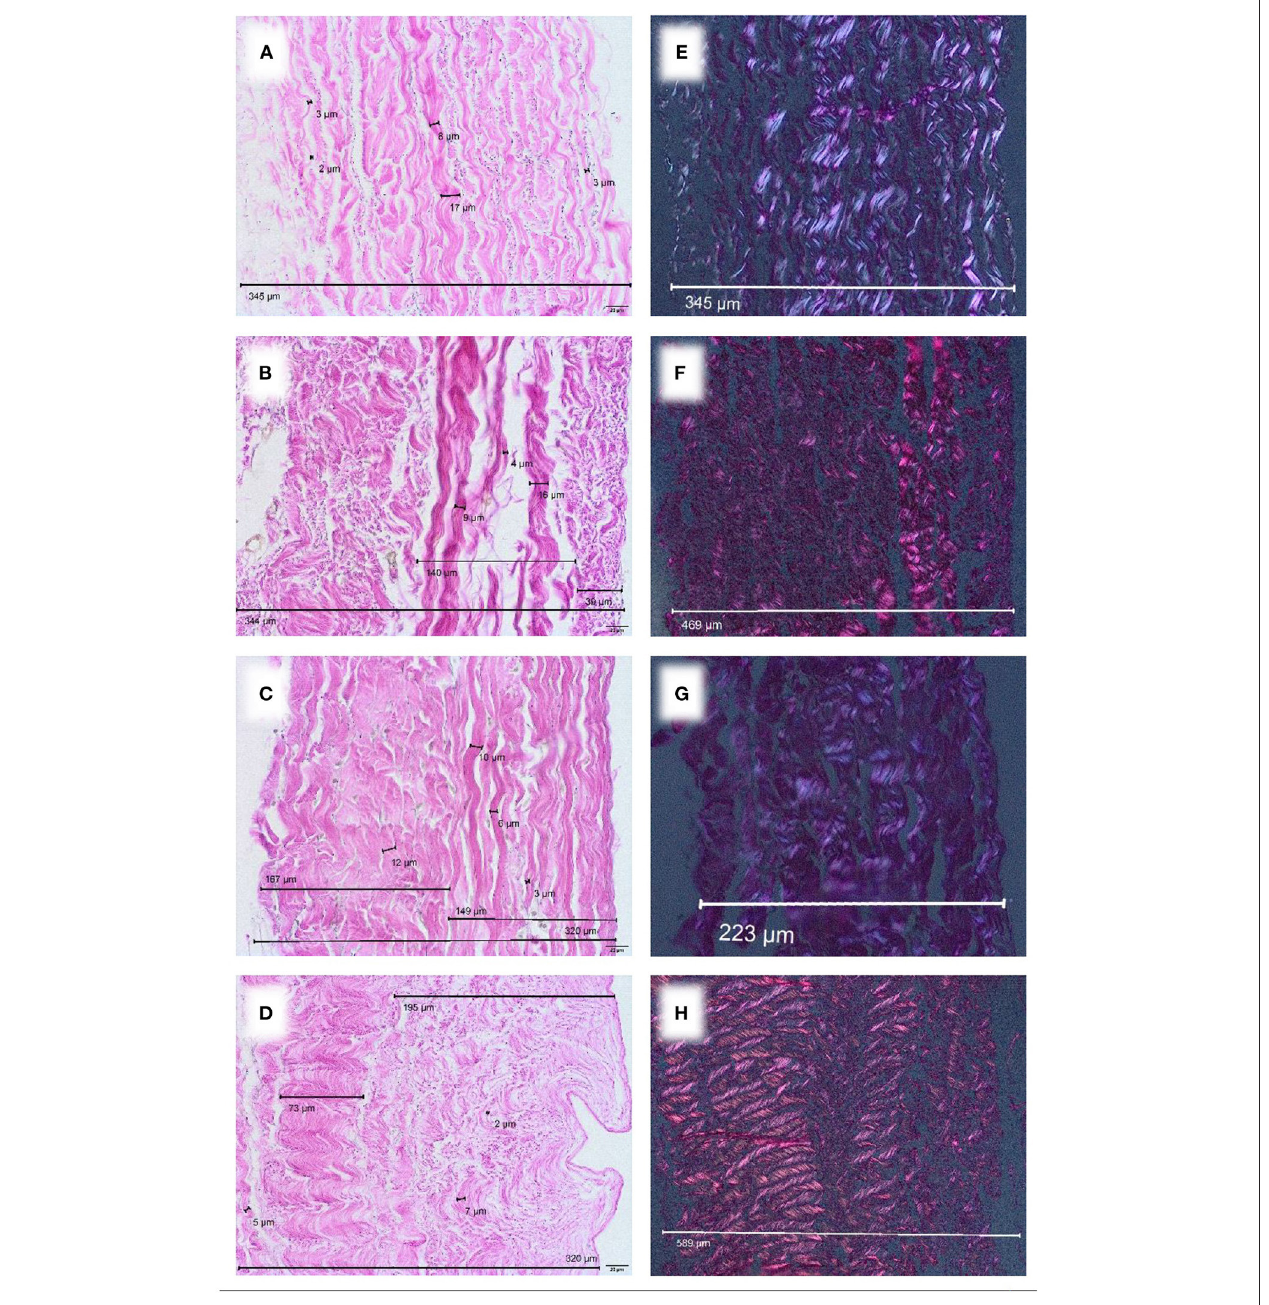
FIGURE 3 | Commercially available patches of different species, EvG staining, Obj. 40x. (A) CardioCel ® patch (bovine), (B) VascuGuard ® patch (bovine), (C) BioIntegral Curved No-React® patch (porcine), (D) Matrix patch TM (equine). Polarization, EvG staining, Obj. 20x. (E) CardioCel ® patch (bovine), (F) VascuGuard ® patch (bovine), (G) BioIntegral Curved No-React® patch (porcine), (H) Matrix patch TM